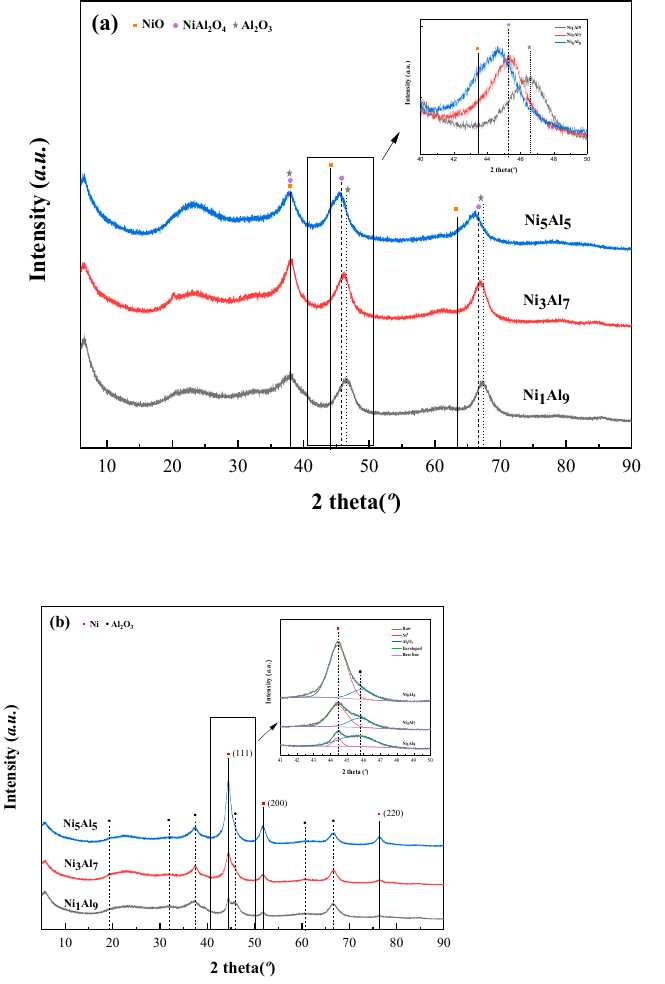
Figure 1. X-ray diffractograms of NiAl 2 O 4 with various Ni/Al ratios: ( a ) catalysts before reduction and ( b ) catalysts after reduction. Table 1. Ni crystallite size determined by X-ray diffraction (XRD), transition electron microscopy (TEM), and O 2 chemisorption of the NiAl 2 O 4 catalysts with various Ni/Al ratios (after reduction). Sample d Ni , nm (XRD) d Ni , nm (TEM) d Ni , nm (O 2 Chemisorption)